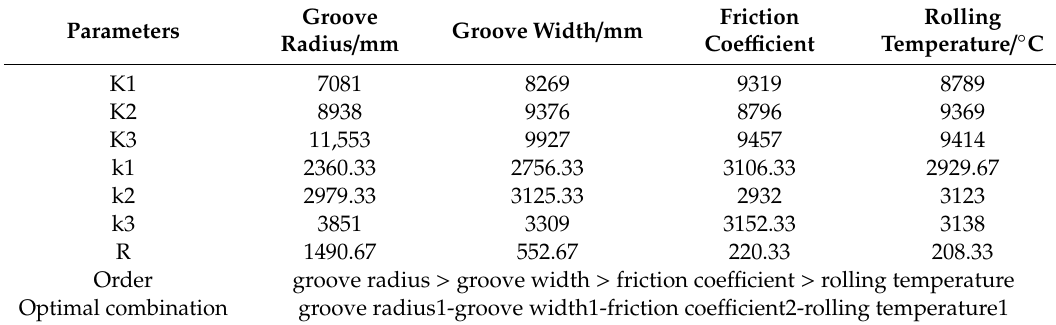
Table 6. Analysis of the simulation results using the range